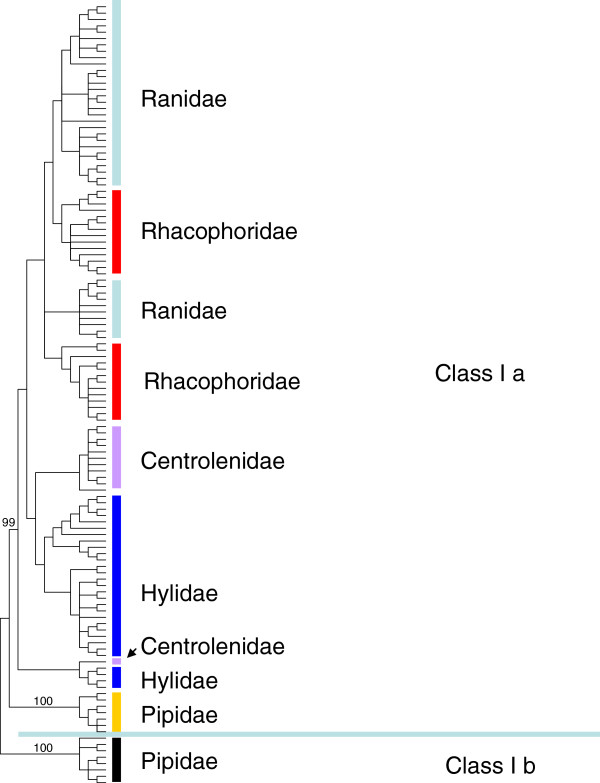
Phylogenetic relationships of anuran MHC class Ia and Ib genes. The neighbor-joining tree was constructed with MEGA5 using all available anuran MHC class I genes with a sufficient length. Bootstrap values are indicated above the branches. Sample names are not shown due to the large size of the tree. Rather, the families to which these samples belong are denoted with different colors. The blue horizontal line separates MHC class Ia genes (above the line) and MHC class Ib genes (below the line). Alleles in this tree include the following: the 27 alleles isolated in the present study (family Rhacophoridae); MHC class Ia alleles from the family Hylidae (19 alleles from A. callidryas: JQ679312-JQ679330; 11 alleles from S. phaeota: JQ679380-JQ679390, [44]); from family Centrolenidae (12 alleles from E. prosoblepon: JQ679331-JQ679342, [44]); from family Ranidae (12 alleles from R. catesbeiana: JQ679343-JQ679354; 16 alleles from R. clamitans: JQ679355-JQ679370; 9 alleles from R. yavapaiensis: JQ679371-JQ679379, [44]; 2 alleles from R. pipiens: AF185587-AF185588, [72]); from family Pipidae ( 5 alleles from X. tropicalis: BC167634, BC161748, BC154904, [73]; NM_001112910, NM_001113065, [74]); 2 alleles from X. laevis: (NM_001085732, [72]; NM_001086402, [73]); and MHC class Ib alleles from family Pipidae (6 alleles from X. laevis: L20726, L20730, L20732, [6]; FJ589642- FJ589643, [75]; NM_001135072, [72]; 2 MHC Ib alleles from X. tropicalis: NM_001037273, NM_001247995, [72]).